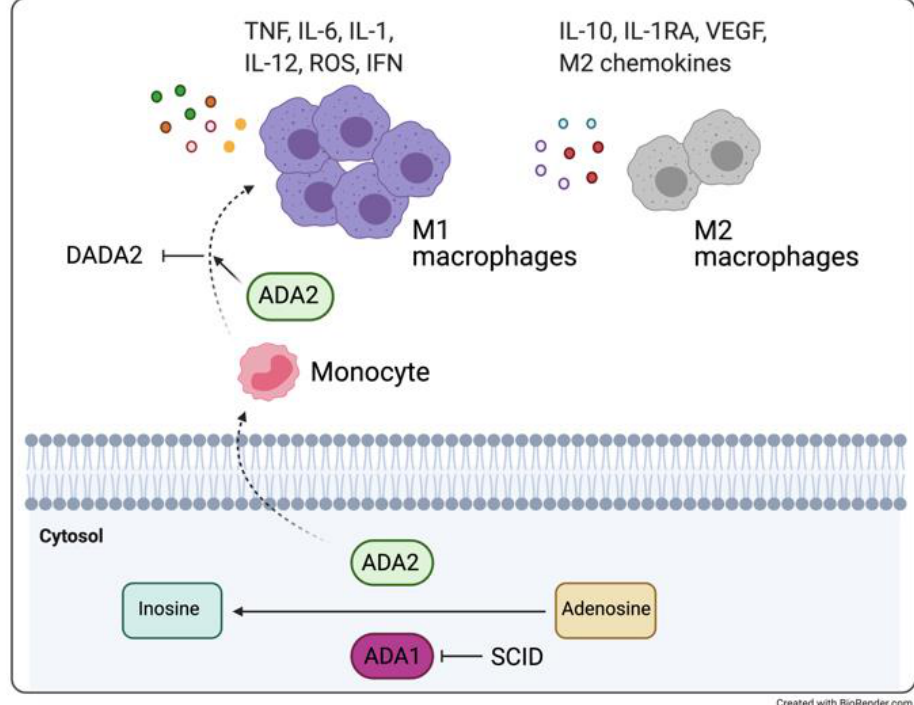
Figure 2. Like ADA1, ADA2 is involved in the conversion of adenosine into inosine. On one hand, a deficit of ADA1 protein is responsible for the development of severe combined immunodeficiency (SCID), on the other hand, ADA2 deficiency is associated with reduction of M2 macrophages and polarization towards M1 macrophages, with consequent increased production of proinflammatory cytokines and endothelium damage and fibrosis, and DADA2 disease. Figure adapted from [87].